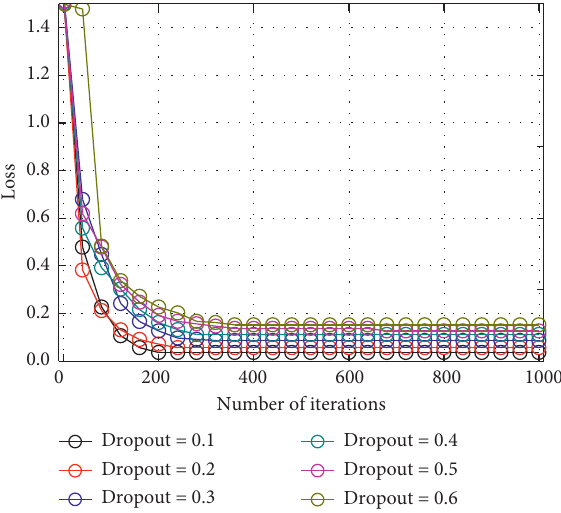
Figure 12: Comparison of training loss value of six training methods. Table 4: Influence of different training methods on the training effect of deep reconstruction network algorithm.